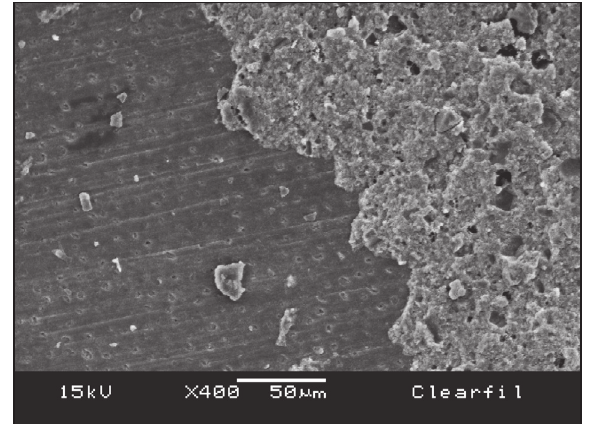
Figure 5 - Mixed failure mode (type 4) showing the dentin surface and remnants of Clearfil SA resin cement (original magnification 400 ×